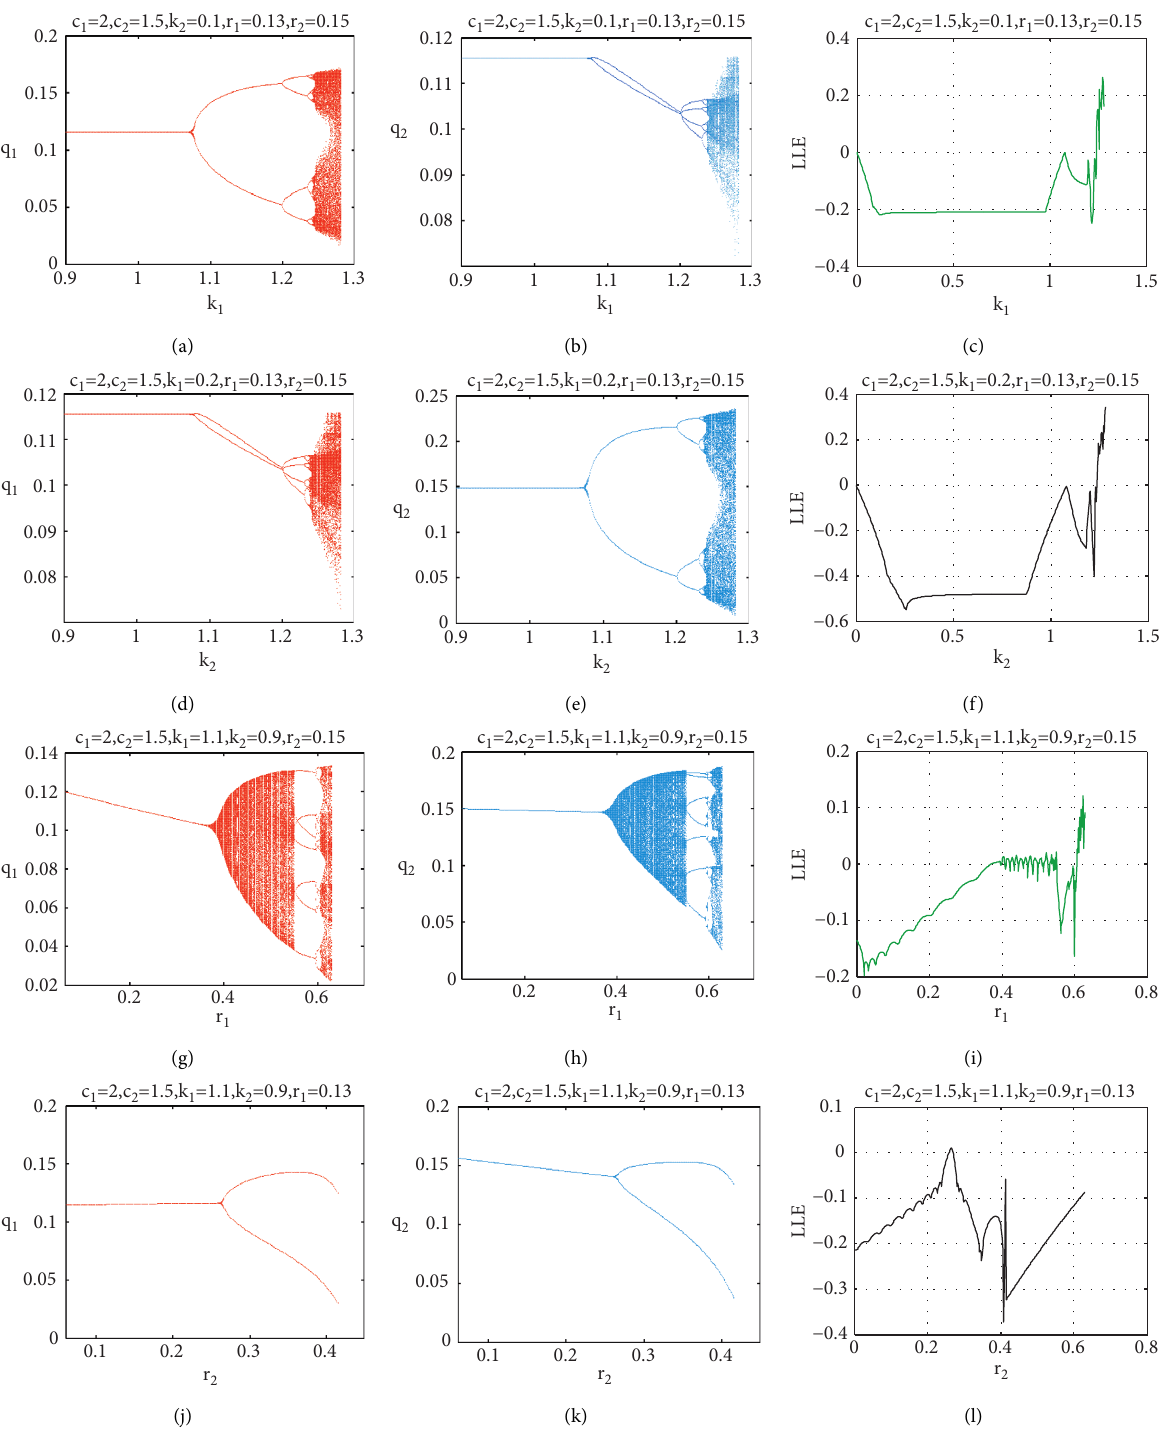
Figure 1: (a–l) Different types of bifurcation diagrams with respect to the parameters r Lyapunov exponents. Each figure is plotted at some parameters values given in the text and within the figure